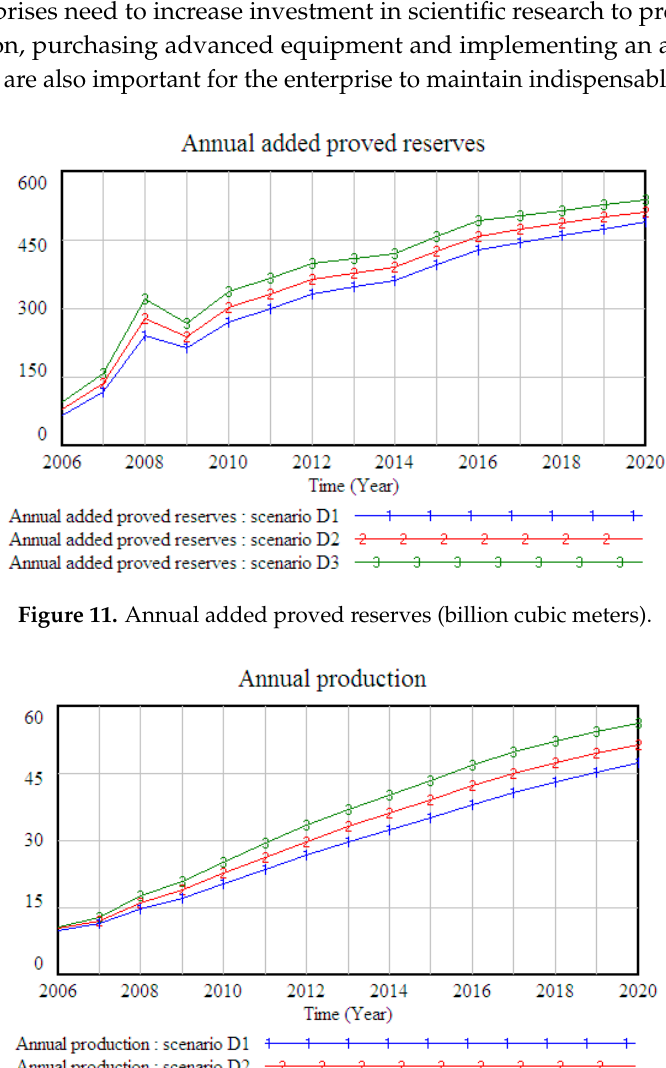
Figure 13. Reserve/production ratio.